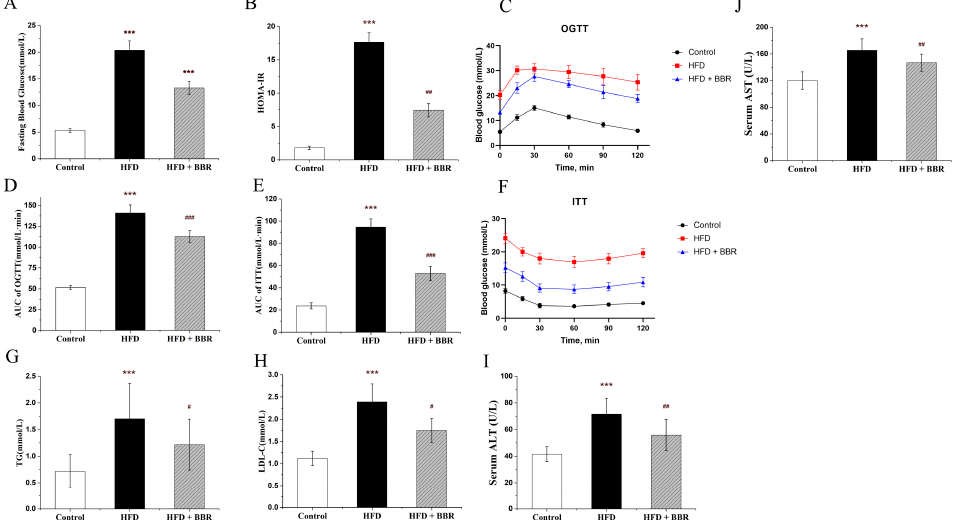
Figure 1. BBR improved insulin resistance and lipid disorder in vivo. ( A ) Fasting blood insulin level; ( B ) Homa-IR; ( C , D ) oral glucose tolerance test (OGTT); ( E , F ) insulin tolerance test (ITT); ( G ) triglyceride (TG); ( H ) low-density lipoprotein (LDL); ( I ) serum ALT level; ( J ) serum AST level. Data are presented as the mean value ±SE ( n ≥ 6): *** p < 0.001 compared to the control group. # p < 0.05, ## p < 0.01, and ### p < 0.001 compared to the HFD group.